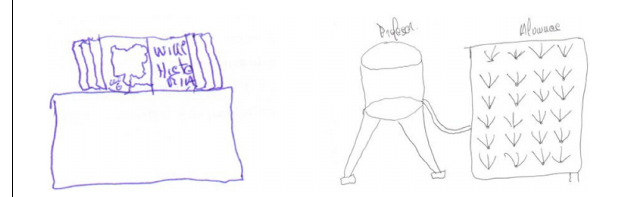
FIGURE 2 | E20’s teacher metaphor drawings as encyclopaedia (in the pre-test) and water tank (post-test).